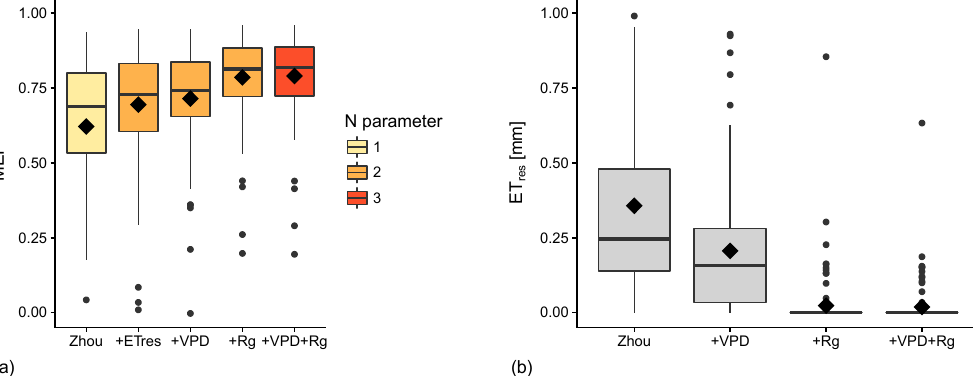
Figure 4. Cross-validated MEFs of the model variants with additional covariates (a) . The thick horizontal lines of the box plots denote the median and the diamonds denote the mean of the MEF of all sites. The + Rg variant led to a further increase in model performance when comparing to the + ET res variant. By contrast, the + VPD variant showed only a small increase in performance. Global distribution of the residual intercept for all model variants (b) .